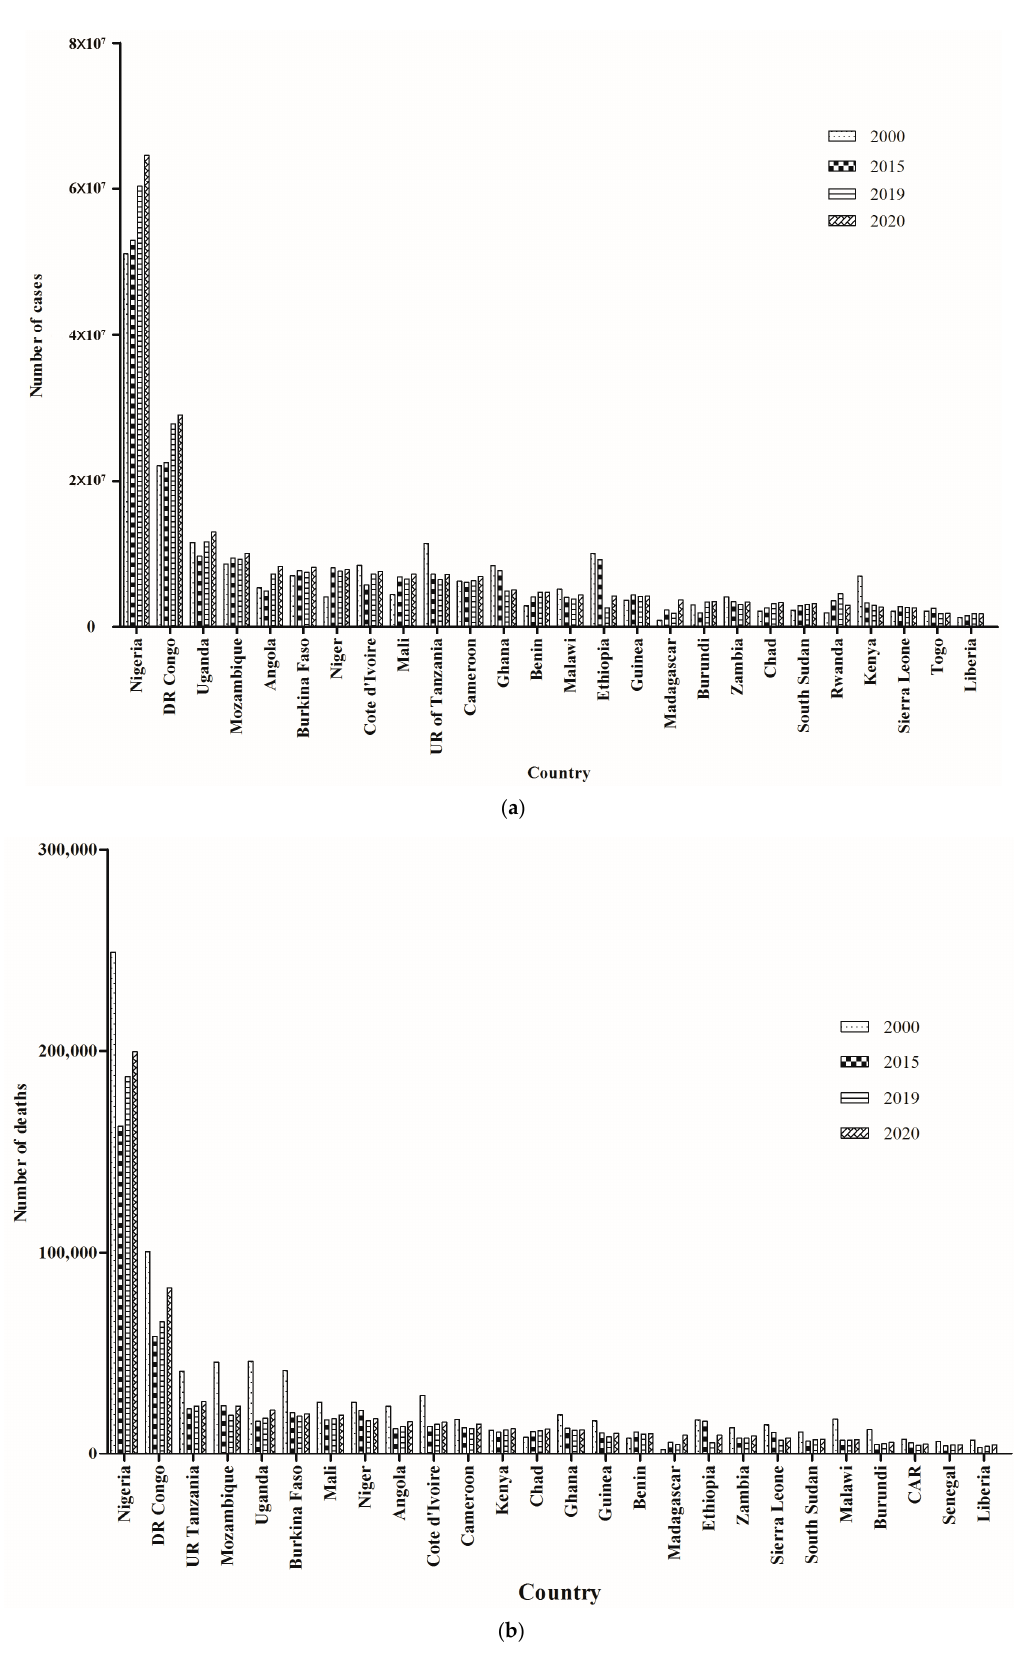
Figure 4. Comparison of the number of cases ( a ) and deaths ( b ) resulting from malaria in African countries across 4 years.